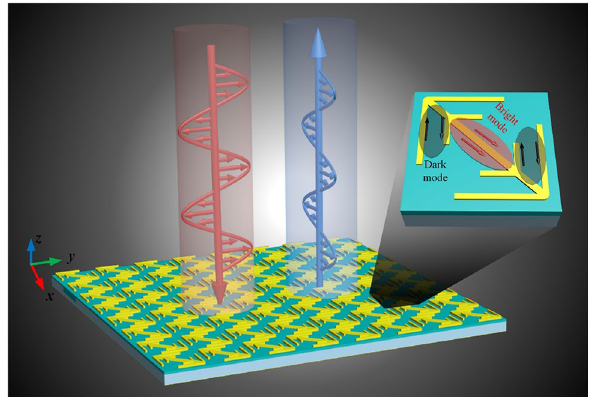
Figure 1. Schematic of polarization conversion using Fano resonance formed by interaction between dark mode and bright mode.